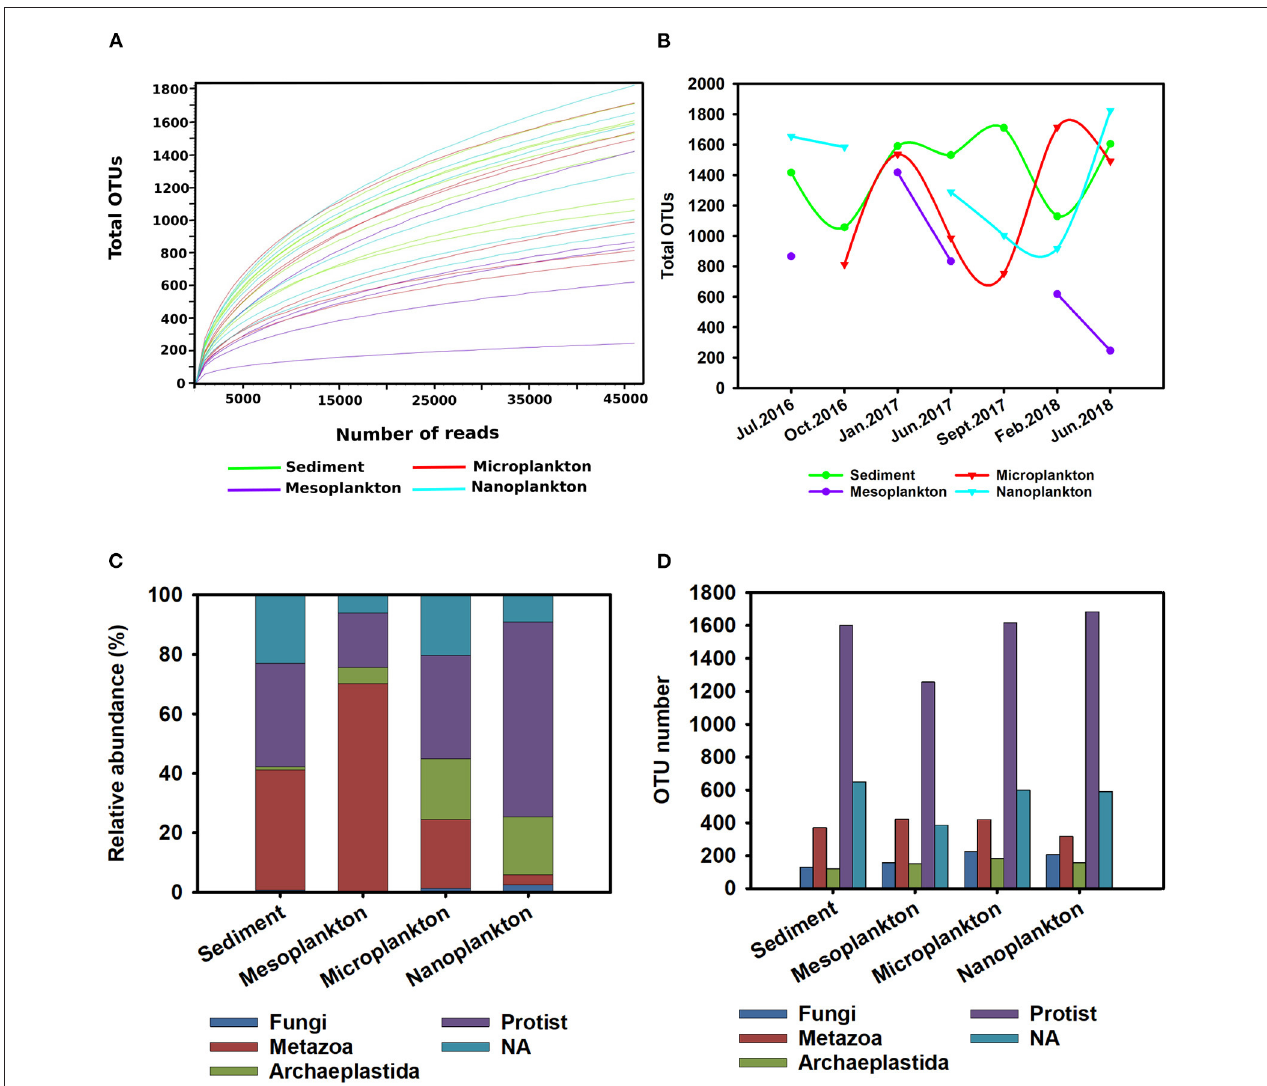
FIGURE 2 | Overview of eukaryotic diversity. (A) Rarefaction curves constructed to analyse the alpha diversity in the environmental samples. A subsampling depth of 46,108 reads was used. (B) Seasonal variations in the alpha diversity registered during the sampling period. (C,D) General description of eukaryotic diversity [protist, metazoan, Archaeplastida, Fungi, and non-classified eukaryotes (NA group)] presented in the environment. The relative abundance (percentage) of the different taxonomic groups in environmental samples (C) is shown. The richness of the different taxonomic groups based on the number of OTUs included in each group was analyzed (D)